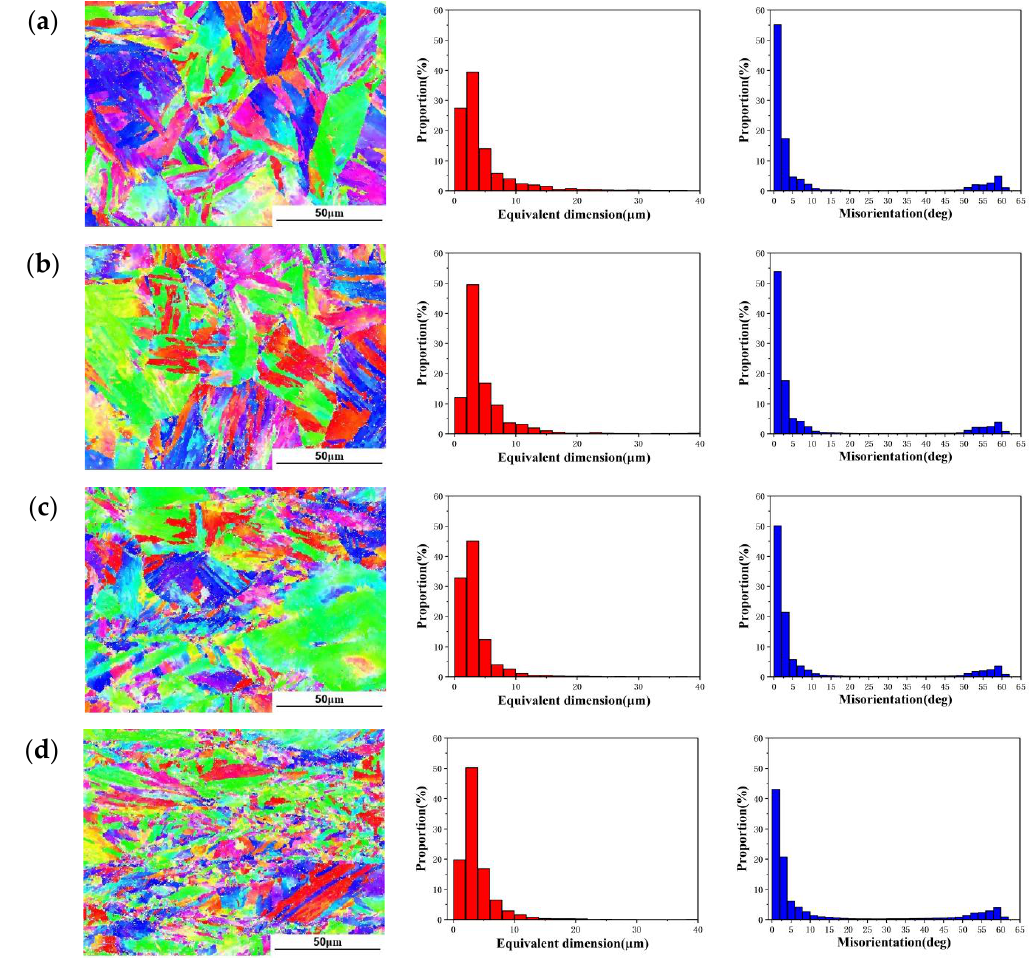
Figure 8. The distribution and dimensions of the martensite lath and the distributions of grain boundary misorientation after deformation: ( a ) 15%; ( b ) 30%; ( c ) 45%; ( d ) 60%. The distributions of grain boundary misorientation of 18Ni(250) steel under different forging conditions are shown in Figure 8. As the deformation amount increases, the pro- portion of low-angle boundaries less than 10° gradually decreases, from 83.3% to 76.65%, and the proportion of high-angle boundaries of 50° to 60° gradually increases. This means that as the deformation amount increases, the low-angle boundaries gradually transform into high-angle boundaries. Because a large number of dislocations are generated inside the grains during the deformation process, the motion of the slip system in different re- gions is different, and the sub boundary is gradually formed. The sub boundary in the austenite is the low-angle boundary; recrystallization that occurs at this position gradually transforms the low-angle boundaries into the high-angle boundaries [40]. 3.4. Microstructure Evolution of 18Ni(250) Steel after Heat Treatment The metallographic photographs of 18Ni(250) steel with different deformation amounts are shown in Figure 9. The grain size was calculated by metallographic photo- graphs, and the calculation results are shown in Table 1. After heat treatment, nanoscale precipitates such as Ni 3 Ti, Fe 2 Mo and Fe 7 Mo 6 are precipitated in the maraging steel, which are uniformly and dispersed distributed on the dislocation lines and the martensite lath boundaries, thus affecting the clarity of the microstructure [5,7]. Figure 9. The metallographic photographs of C250 after heat treatment: ( a ) 15%; ( b ) 30%; ( c ) 45%; ( d ) 60%. The distributions of martensite laths with different deformation amounts after heat treatment are shown in Figure 10, and the average sizes of the martensite lath are shown